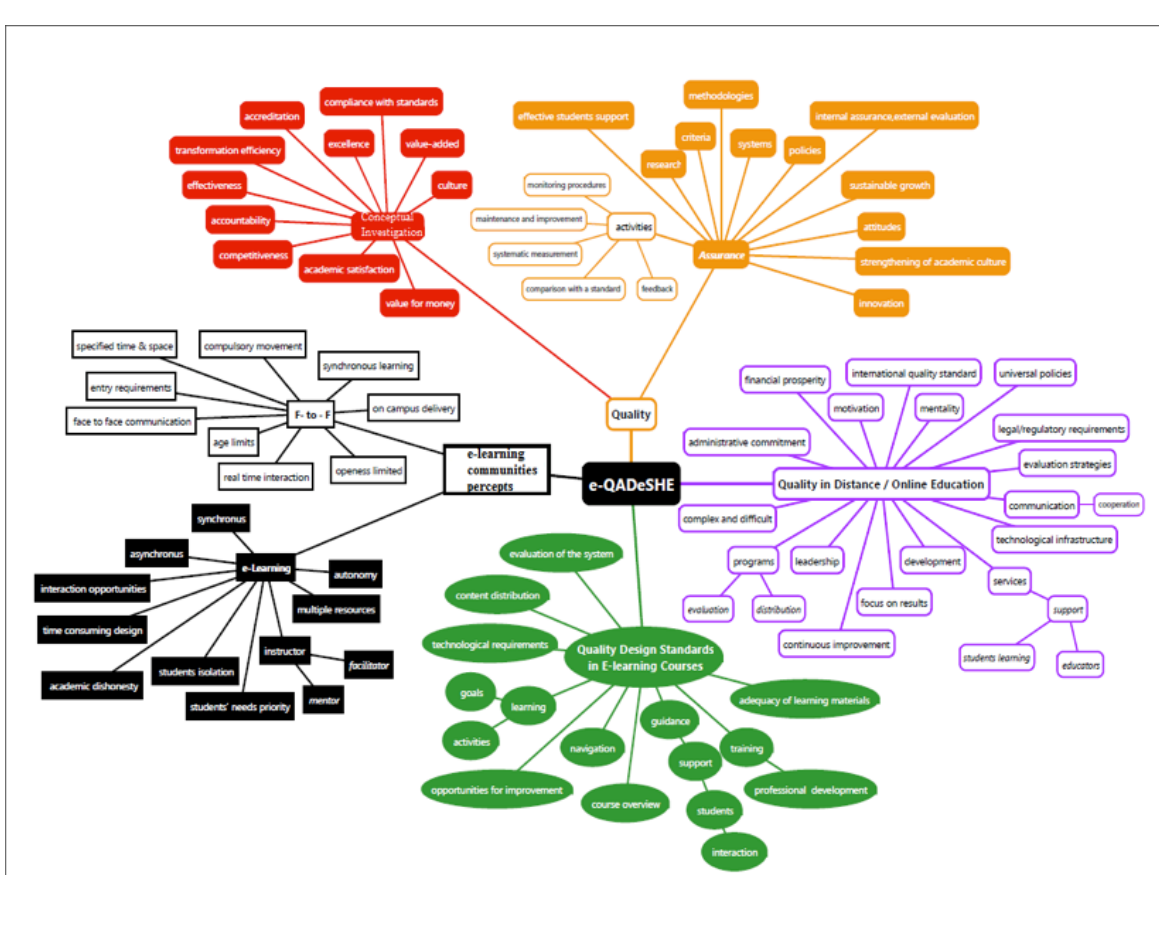
Figure 2. The roadmap of e-QADeSHE project. Sub-areas and the dynamics among them